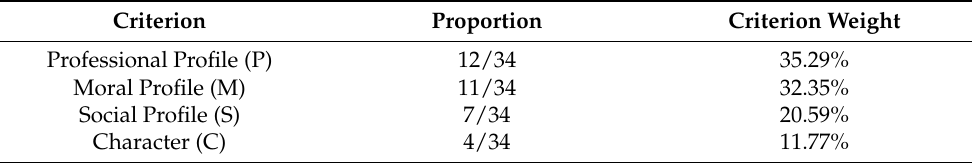
Table 4. Criteria